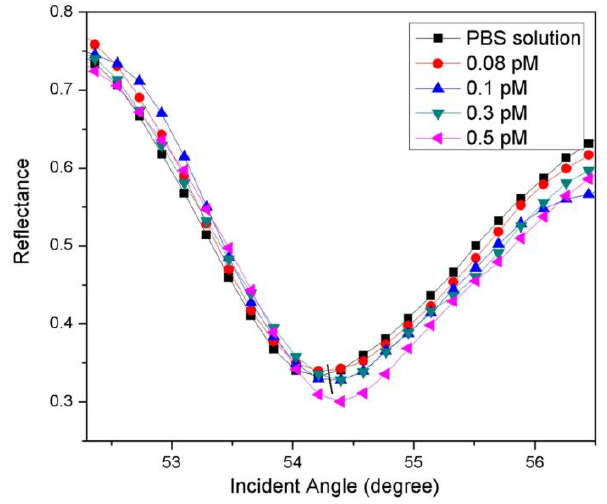
Figure 5. Experimental SPR curves when Au/DSU/NH 2 rGO-PAMAM/IgM sensor film was exposed to 0.08–0.5 pM of DENV-2 E-proteins. Reused with permission from Springer Nature [88].